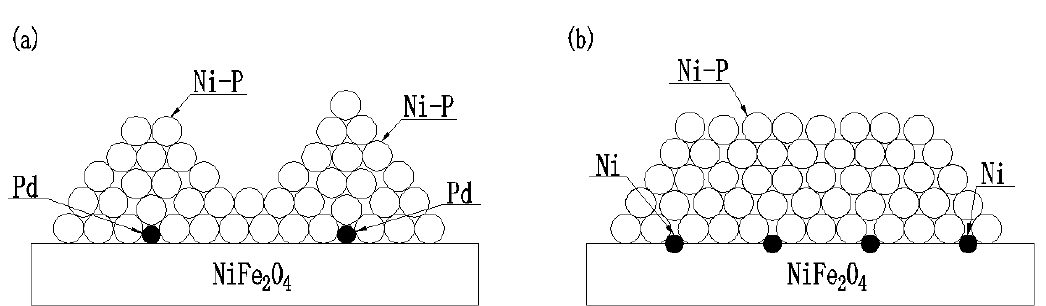
Figure 3. Schematic diagrams of electroless plating process by ( a ) sensitization-activation pretreatment and ( b ) Pd-free activation pretreatment.